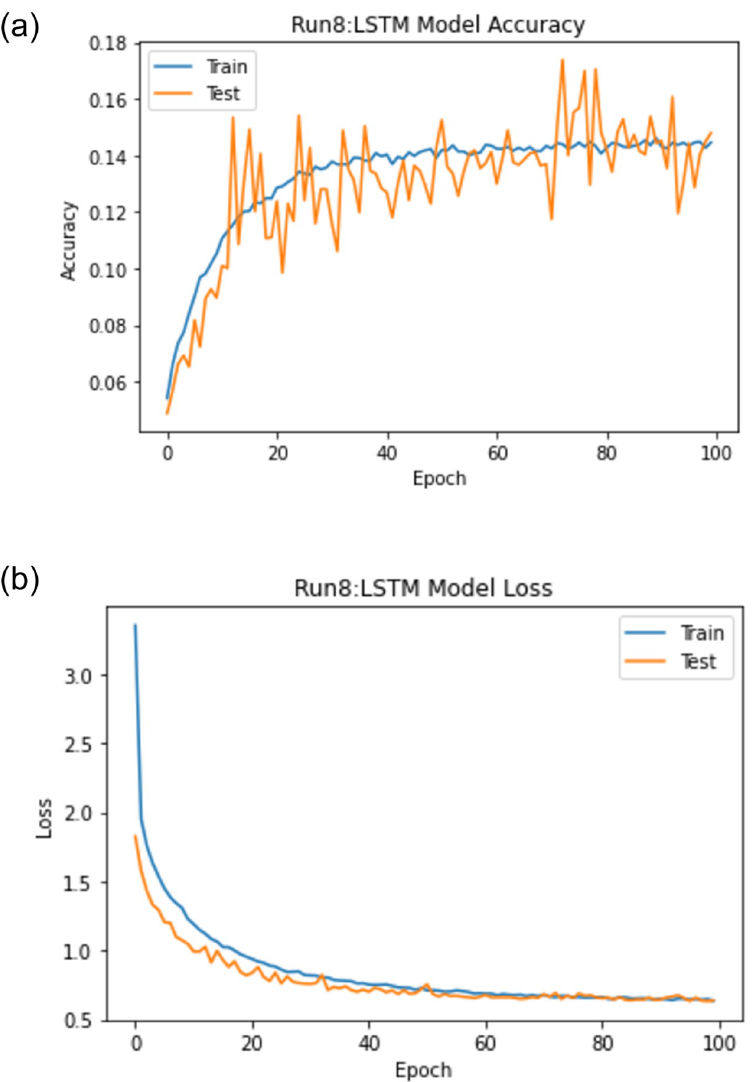
Fig 21. The LSTM-GWO accuracy and loss with experiment